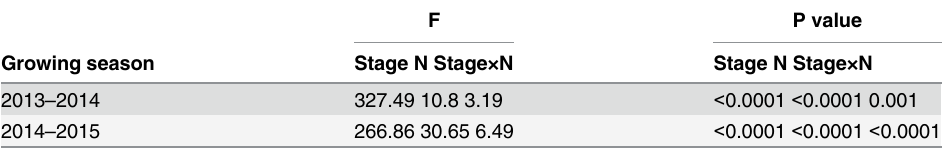
Table 3. Results of two-way ANOVA on the effect of growth stage and N addition on soil respiration during 2013 – 2014 and 2014 – 2015 winter wheat growing season.